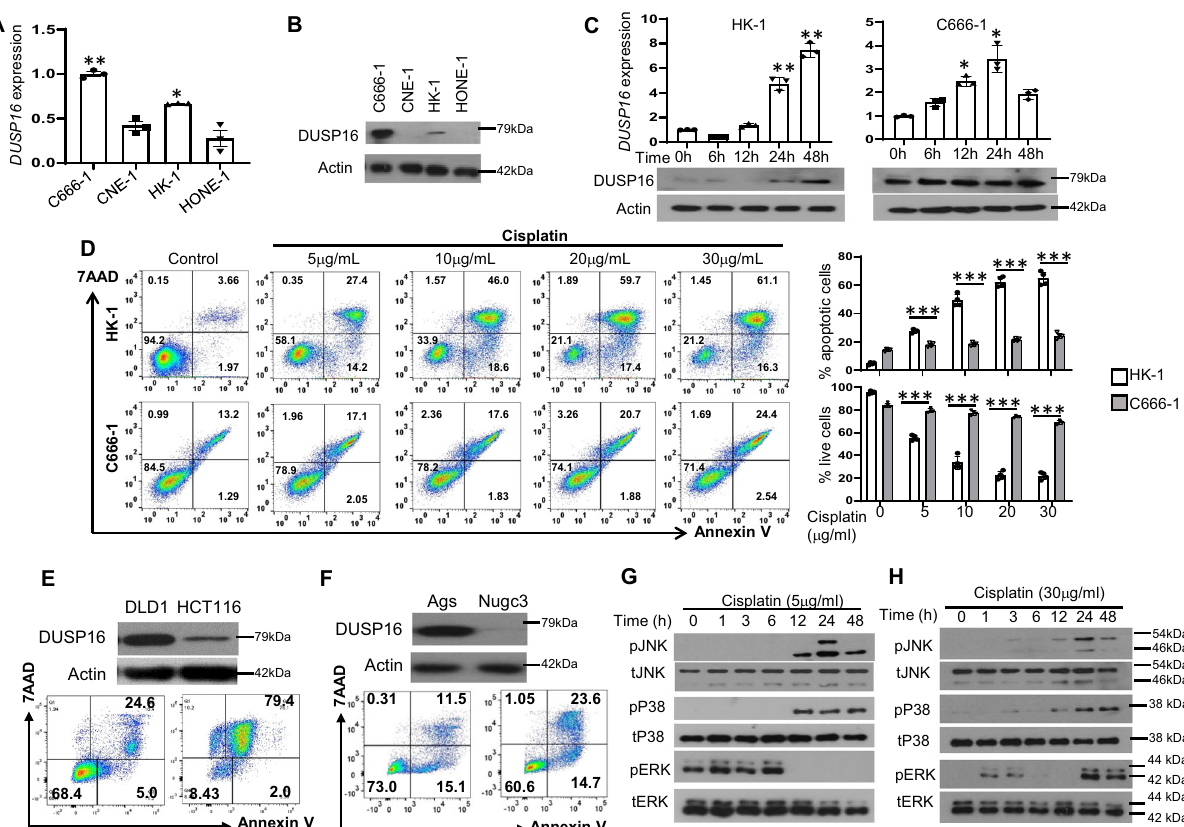
Fig. 1 DUSP16 protein expression level is associated with cancer cell sensitivity to cisplatin. A , B Basal expression levels of DUSP16 in NPC cell lines were determined by quantitative real-time PCR (qPCR). Data were expressed as means ± standard error of the mean (mean± SEM, n = 3 biologically independent samples). Two-tail unpaired t -test showed signi fi cantly higher DUSP16 expression in C666-1 and HK-1 cells compared to that in HONE-1 cells. * P < 0.05, ** P < 0.001 ( A ). DUSP16 protein expression in these cells was determined by western blot analysis. The data are representative of